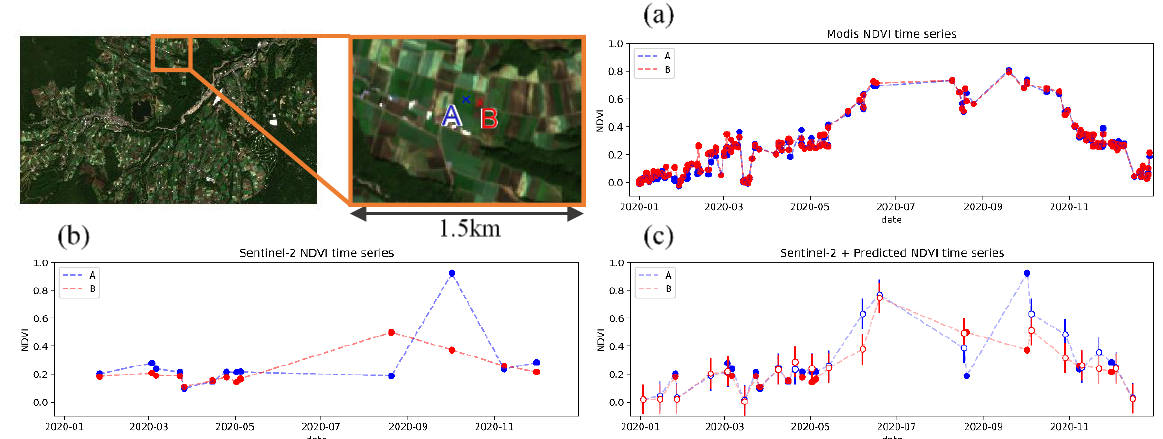
Figure 12. Comparison of NDVI time series plot for adjacent crop fields. (left-top) Location of the target crop fields. Color of the plots represent each field. ( a ) Plot by cloudless MODIS 250-m data. ( b ) Plot by Sentinel-2 10-m data. ( c ) Plot by combination of Sentinel-2 and estimation from the proposed model. Outlined plot represent estimation from the proposed model and error bar shows average MAE (see Section 4.2.4).